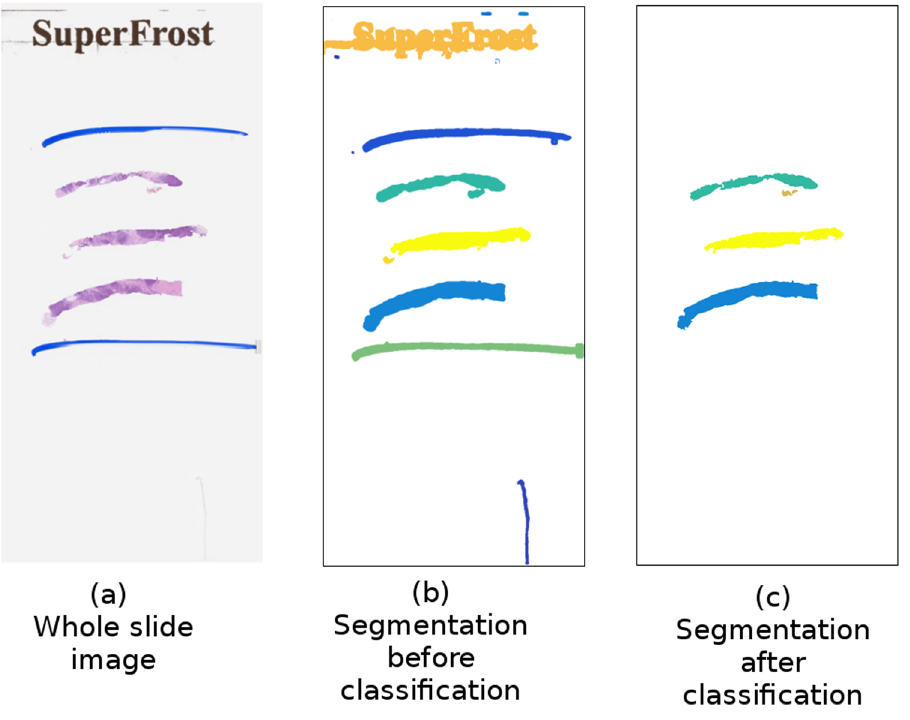
classification has been performed.